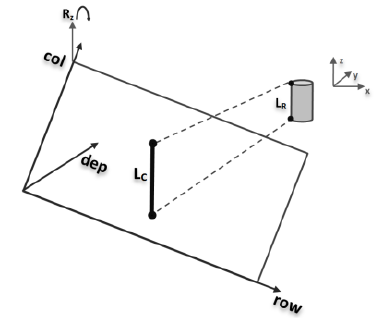
Figure 3. Relationship between the camera space and the real-world space. The rectangle represents an initial image with which the camera space is aligned. The cylinder is an object in real world that is vertical to a horizontal surface. The camera space is represented by its row, column and depth directions (row, col and dep), and the real-world space is represented by the axes (x, y, z). The black line in the rectangle is the projection of the vertical edge of the cylinder onto the